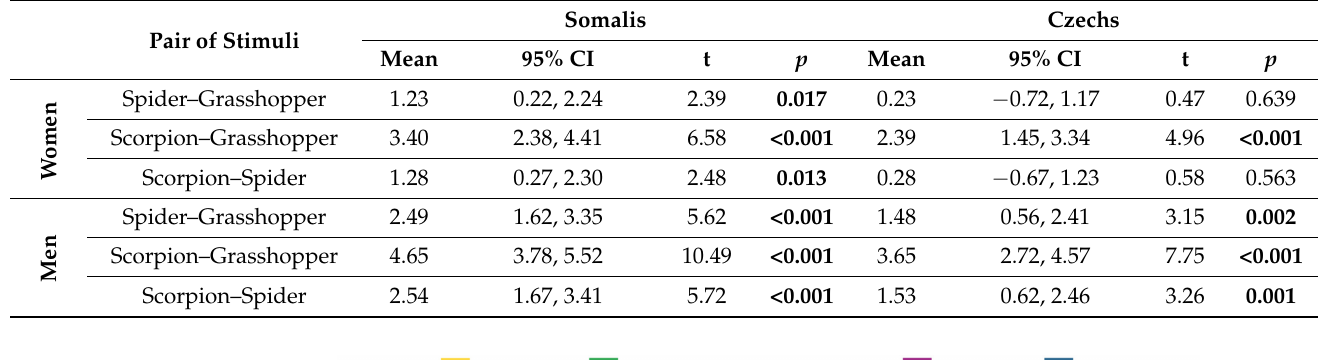
Table 3. Results of the linear mixed effect models for the difference of the number of fixations on the two stimuli − the estimated means for all levels of stimuli pair, nationality, and gender. The predicted estimates are tested against zero − positive values signify more fixations on the former animal in the pair and negative values on the later animal in the pair; p -values < 0.05 are in bold. Somalis Czechs Pair of Stimuli